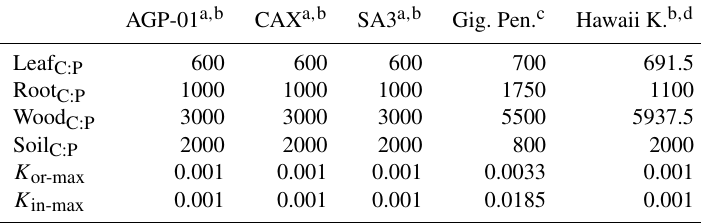
Table 5. Additional test site data used for model